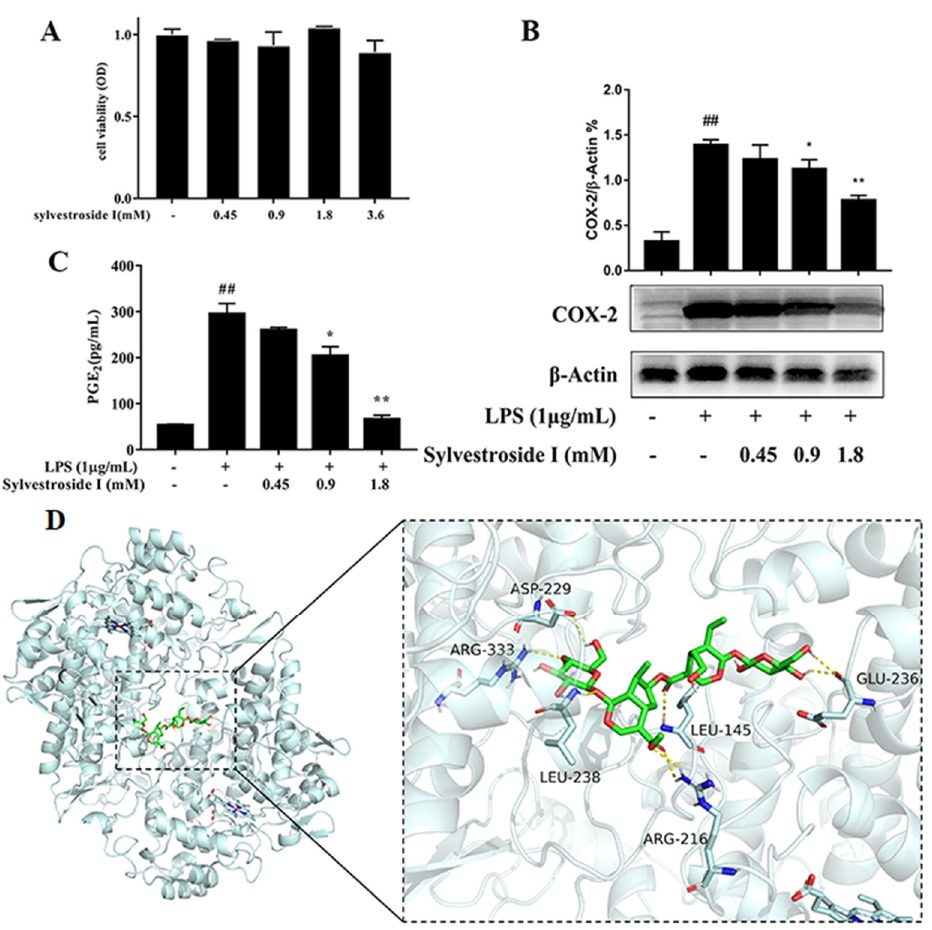
Figure 8. The cytotoxicity assay was conducted to measure the viability of RAW 264.7 cells with sylvestroside I (0.45–3.6 mM) for 24 h ( A ). The expression of COX-2 ( B ) and the PGE 2 levels ( C ) was detected with the treatment of sylvestroside I (0.45–1.8 mM) in LPS-induced RAW 264.7 cells for 24 h. The results were expressed as mean ± SD ( n = 3), ## p < 0.01 compared with the Con group; * p < 0.05, ** p < 0.01 compared with the LPS group. Docking model of sylvestroside I in COX-2 active site ( D ).